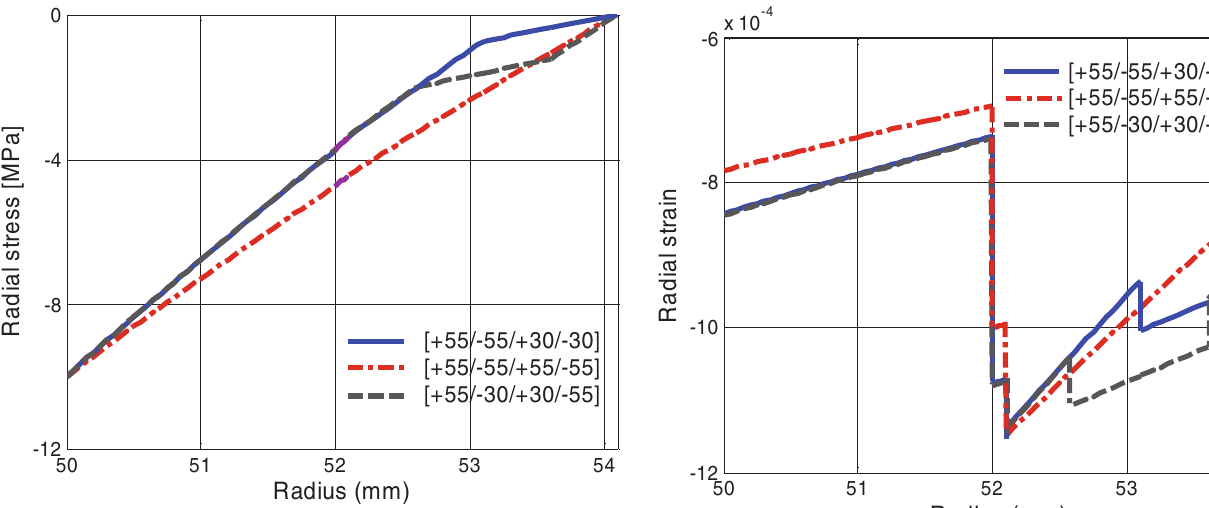
Fig. 4. The distribution of radial stress throught the thickness.